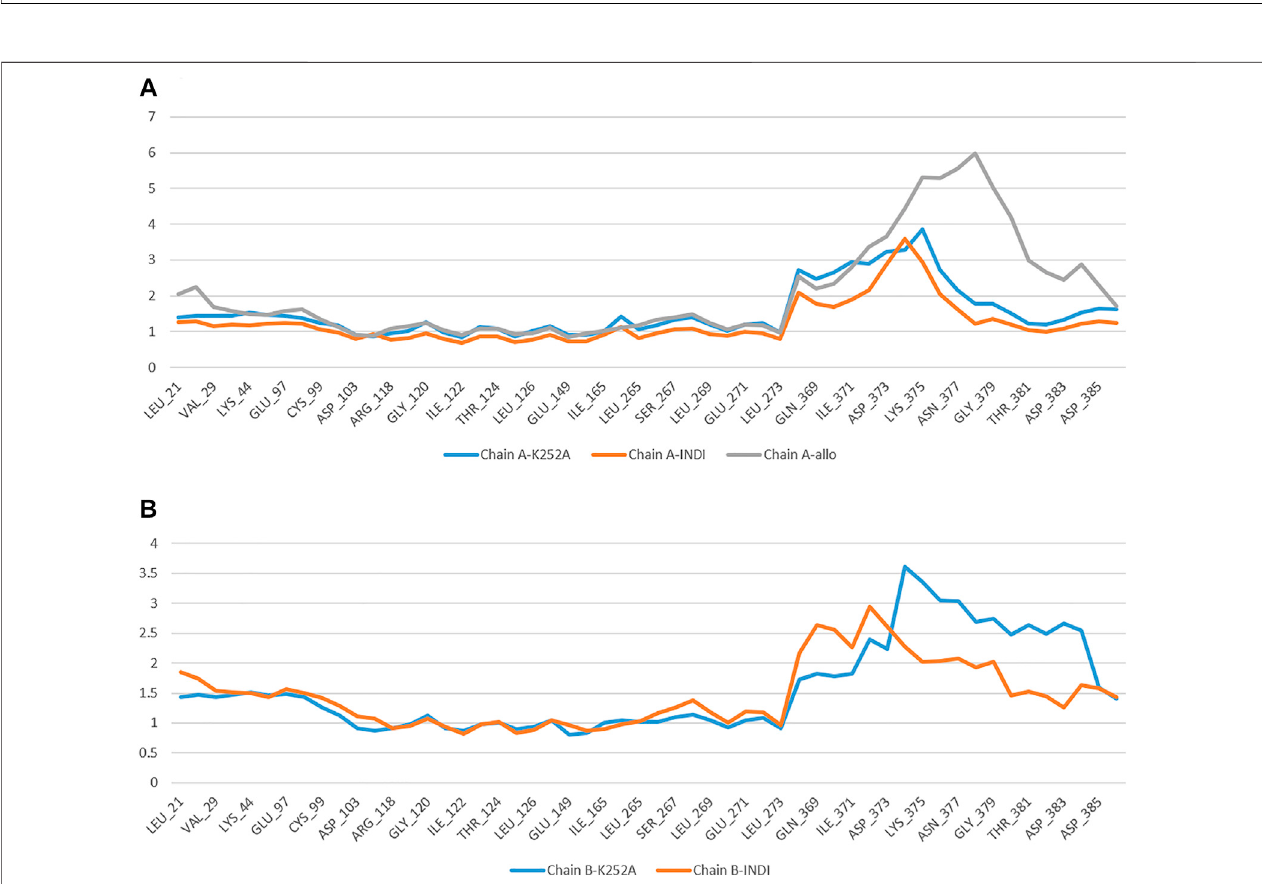
Frontiers in Pharmacology |